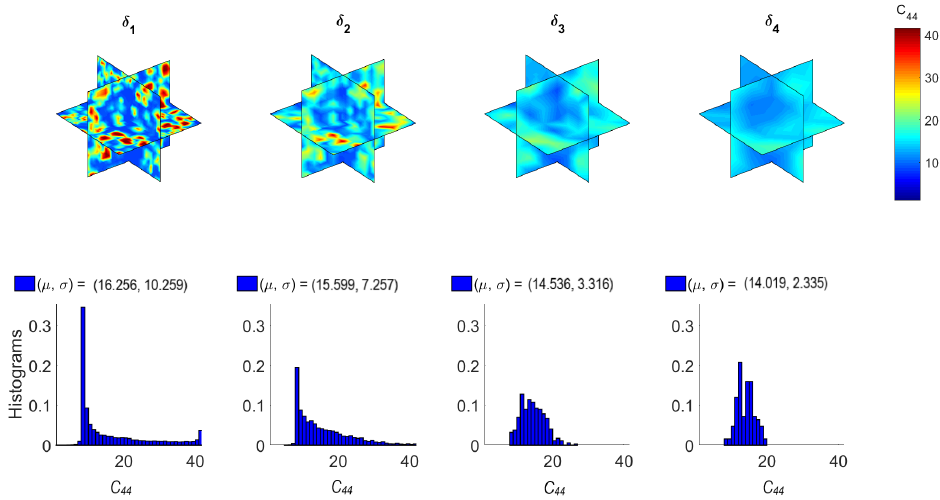
Figure 7. Random fields and histograms of ¯ C 44